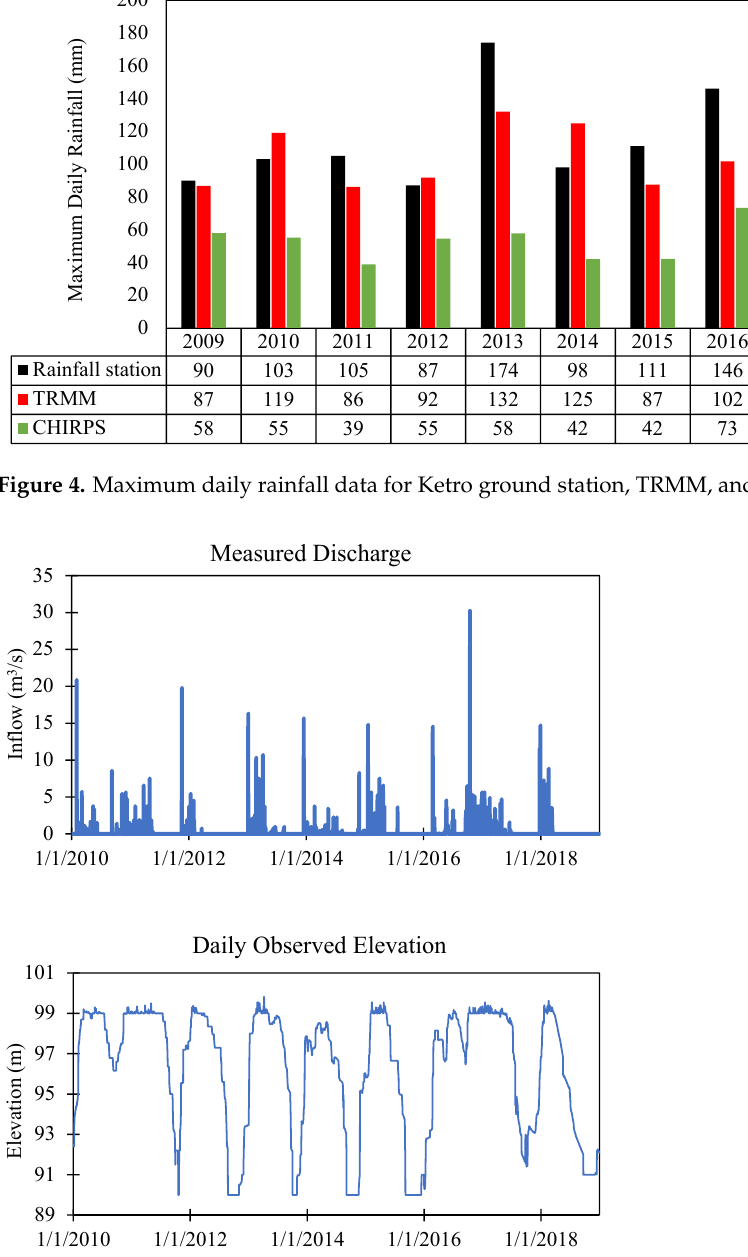
Figure 5. Measured discharge and daily observed water elevation recorded at Ketro dam for